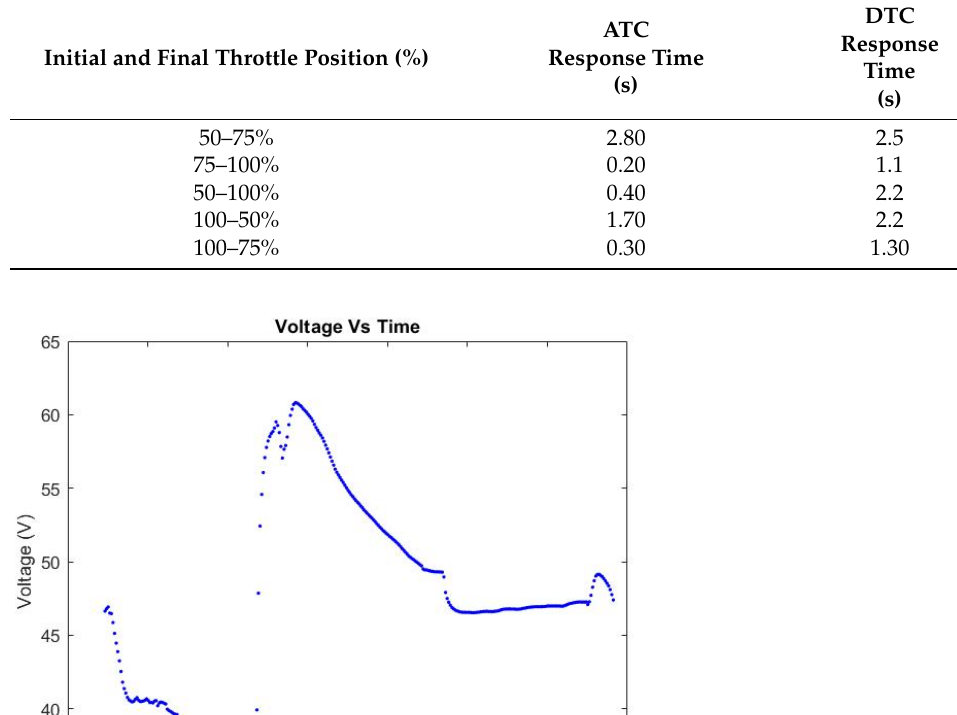
Table 3. ATC and DTC response time.